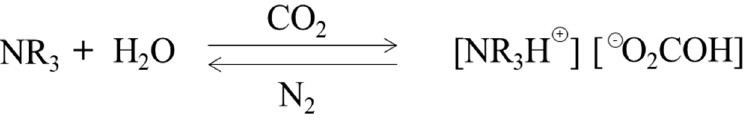
Figure 6. Reaction mechanism from switching hydrophilicity of N,N-dimethylcyclohexylamine. Adapted from [21].